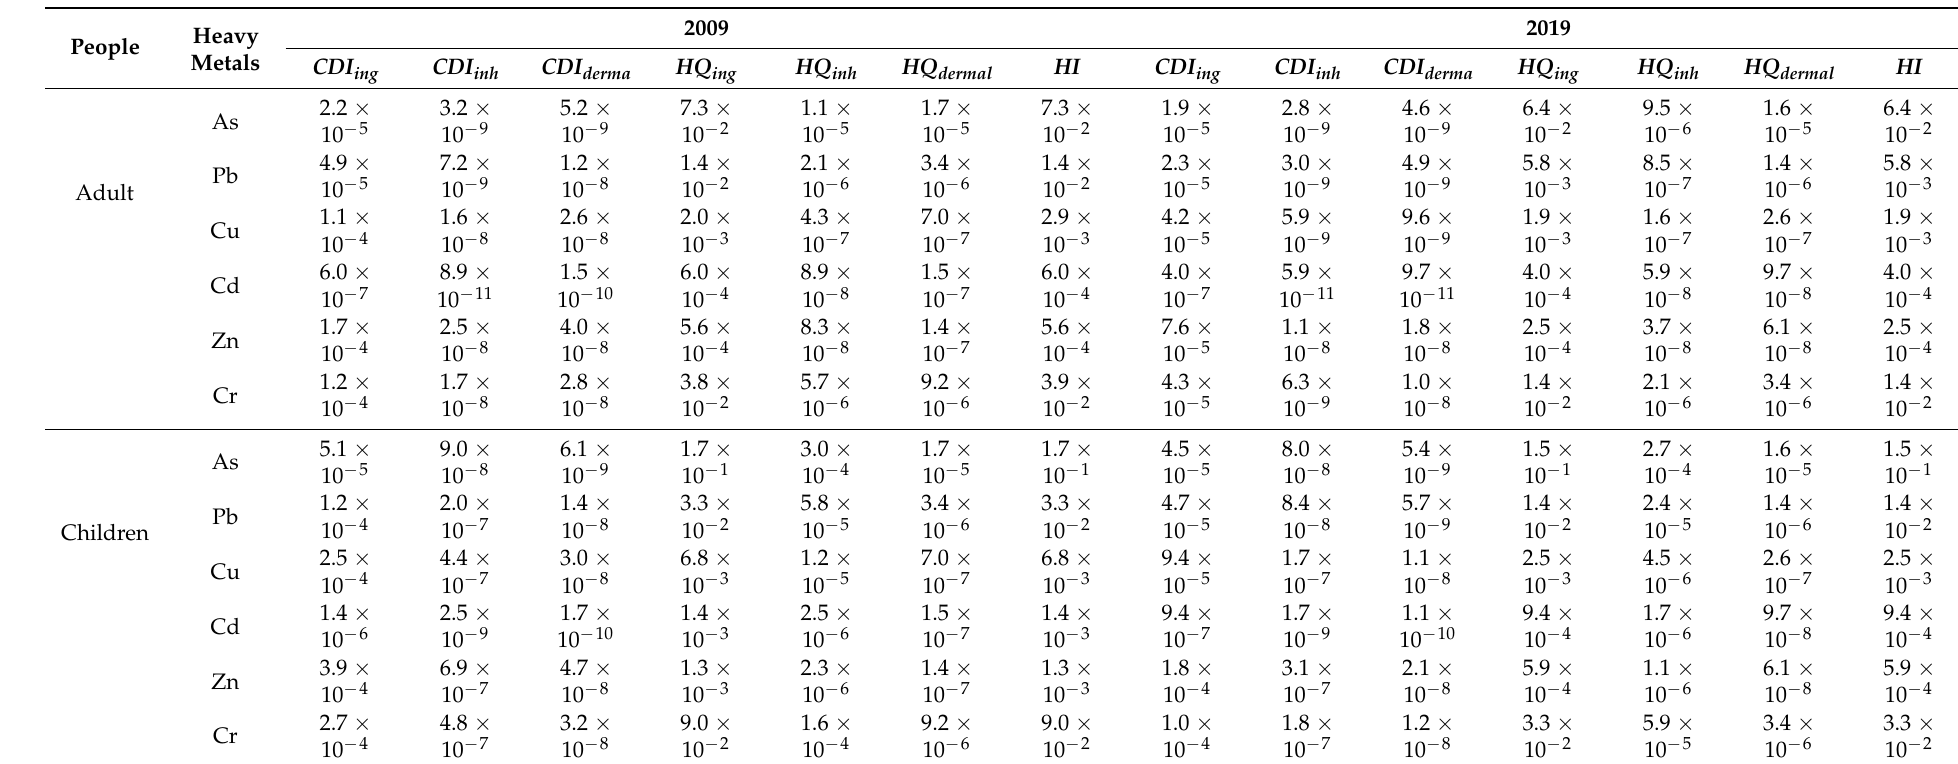
Table 4. Chronic daily intake ( CDI , mg/kg/day), hazard quotient ( HQ ) and cumulative hazard index ( HI ) for non-carcinogenic risk. People